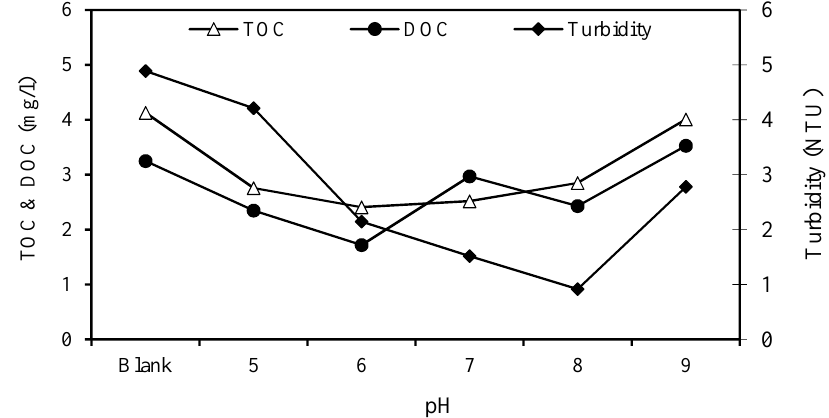
Fig. 1. Effect of pH variations on removal of TOC, DOC, and turbidity in EC process